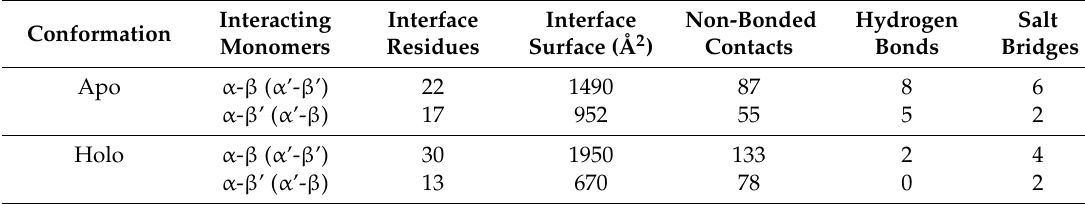
Table 1. PDBsum analysis of the interaction between the Sy InrS protein chains.